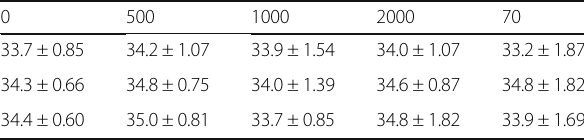
Positive control: Cyclophosphamide